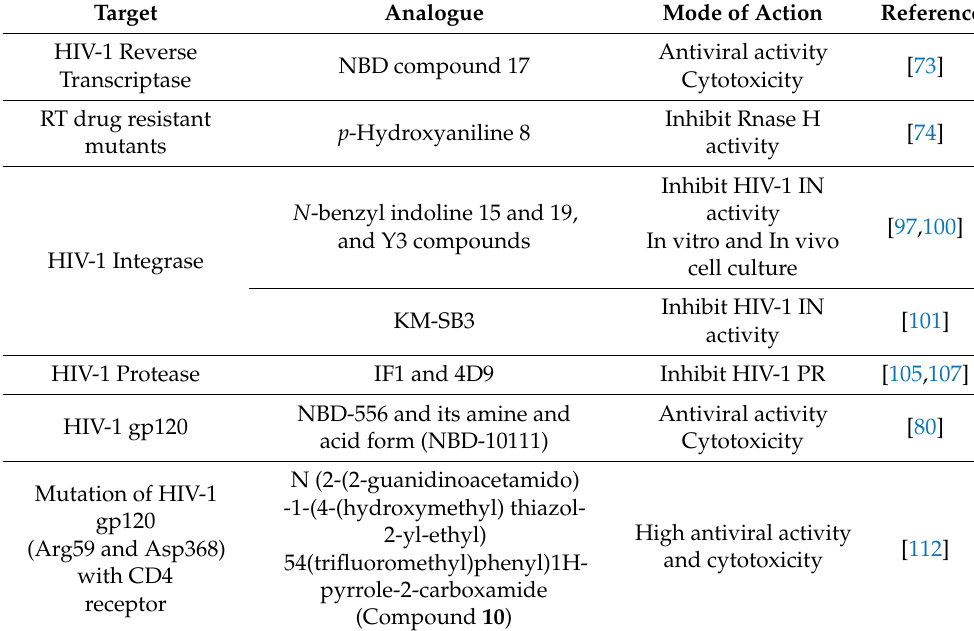
Table 3. HIV targets and its fragment hit molecules with biological